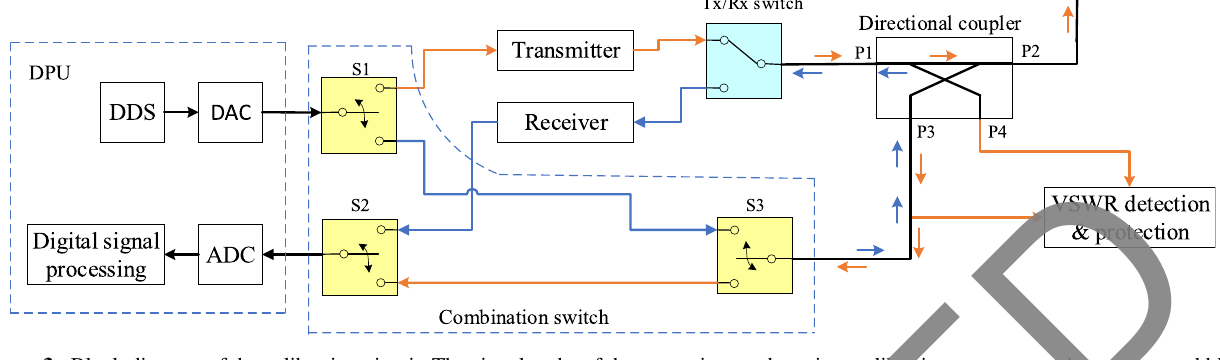
Figure 3. Block diagram of the calibration circuit. The signal paths of the transmitter and receiver calibration are presented as orange and blue, respectively.